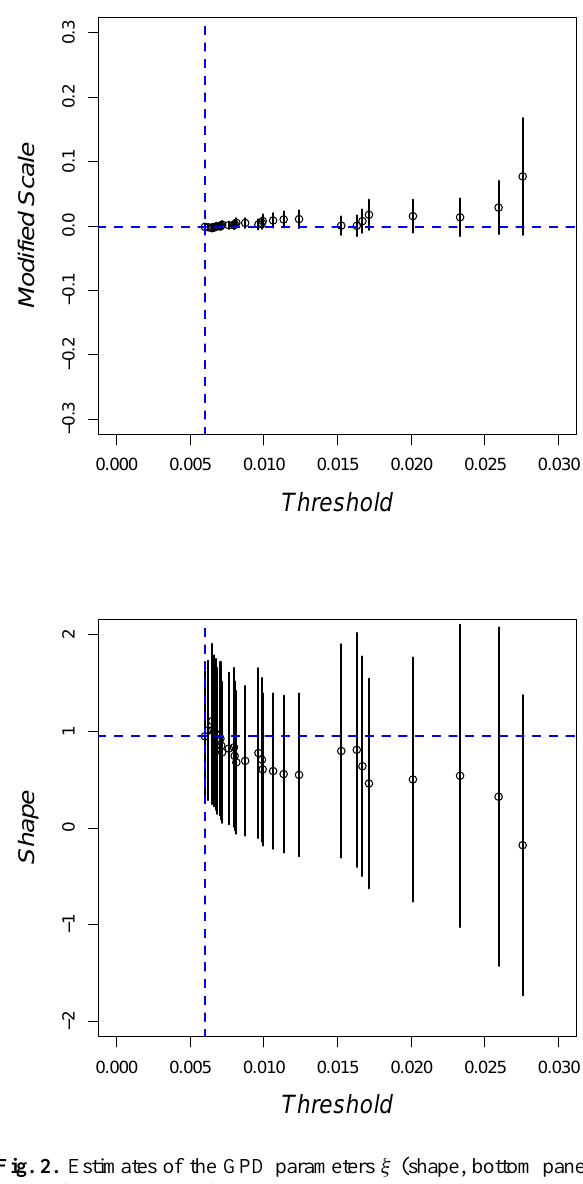
Fig. 2. Estimates of the GPD parameters ξ (shape, bottom panel) and σ (scale, top panel) and the respective 95%-confidence inter- vals (y-axis) for the different thresholds (x-axis). This example shows the threshold optimisation for the extreme value fits of the VGV insurance data. The fit parameters are estimated for all events in the dataset, increasing the threshold for the POT approach one by one. Blue vertical line: optimised threshold (see text for explana- tion); horizontal line: GPD parameters for optimised